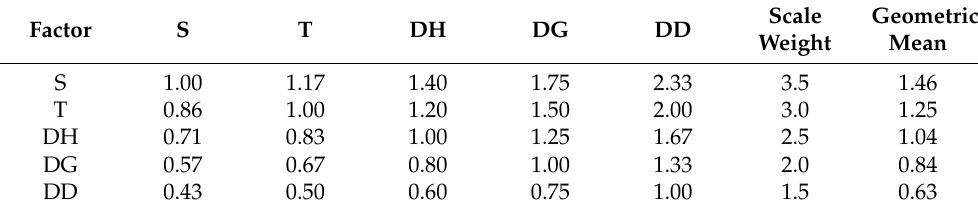
Figure 2. Influence of selected thematic factors related to interflow. Table 1. Normalized pairwise matrix analysis for geometric mean calculation of selected